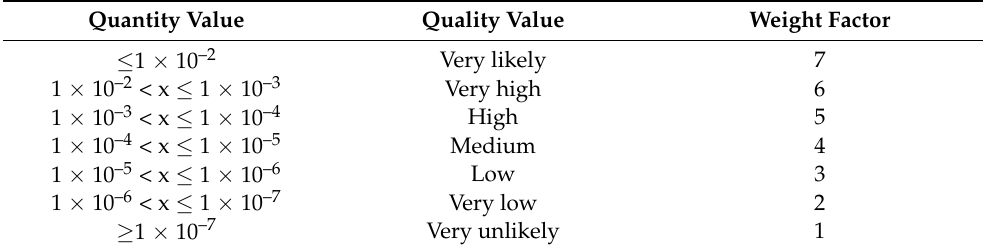
Figure 7. Functional dependence of safety factors and annual failure probability according to the semi-empirical method [24]. Reproduced with permission from publisher Journal of Geotechnical and Geoenvironmental Engineering, F. Silva, T. W. Lambe, W. A. Marr, Probability and risk of slope failure . Journal of Geotechnical and Geoenvironmental Engineering 2008, Vol. 134, No. 12, pp. 1691–1699. Table 6. Interpretation of annual failure probability due to static slope instability.